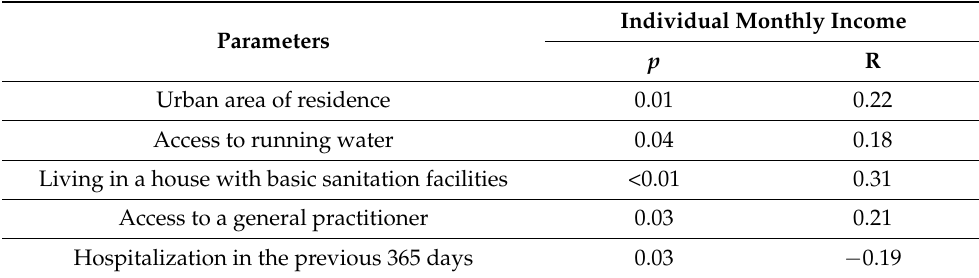
Table 4. Significant correlations between individual income and certain SES, clinical, biological and echocardiographic